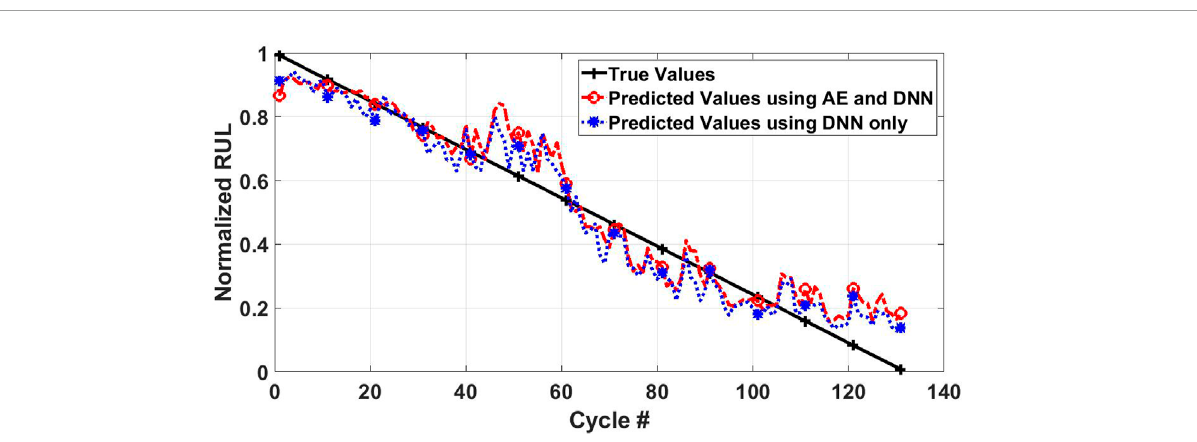
FIGURE 7 Prediction results for DNNwMF when features of n opt = 17 cycles are used in comparison with prediction results for ADNNwMF when features of n opt = 17 cycles are